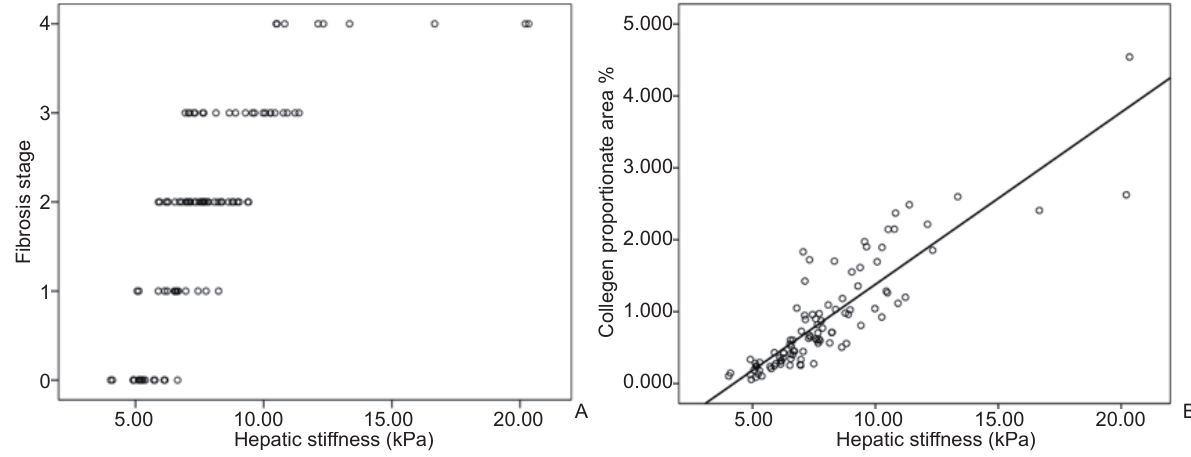
Figure 7 Correlation analysis indicated the hepatic stiffness detected by shear wave elastography (SWE) was positively correlated with histological stages, with the correlation coefficient r = 0.836 ( P < 0.001) (A). Correlation between hepatic stiffness detected by SWE and quantitative measurement of collagen proportionate area (CPA) was strong with correlation coefficient r = 0.889 ( P < 0.001) (B).